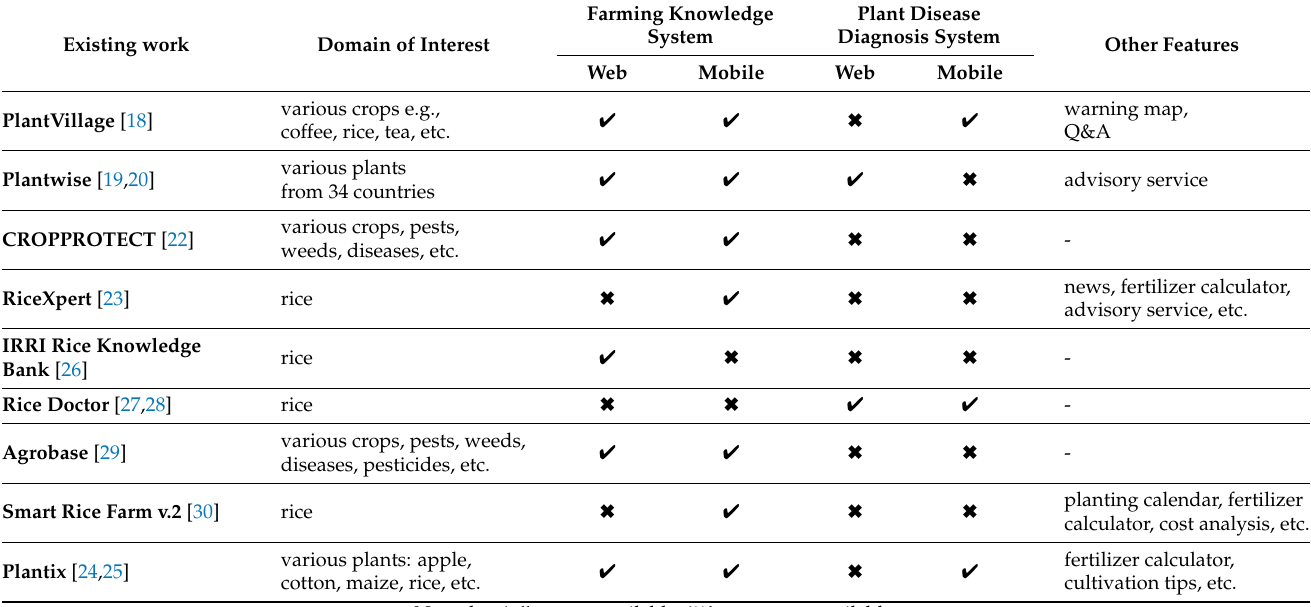
Table 2. A comparison of online farming knowledge portals and diagnosis